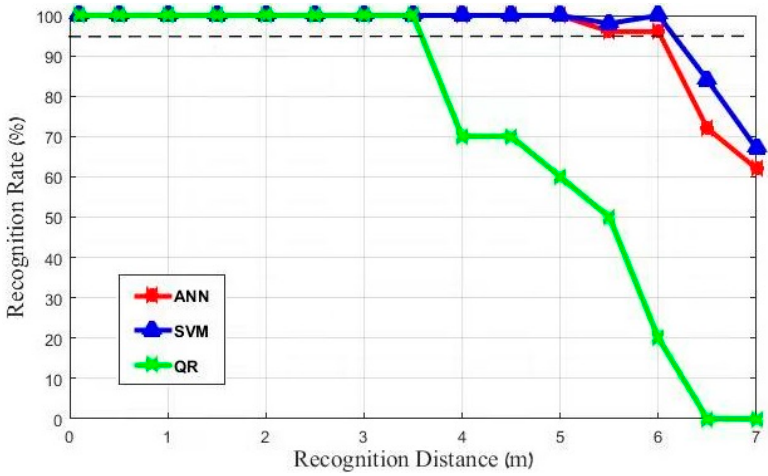
Figure 18. Recognition distance compare with QR code.